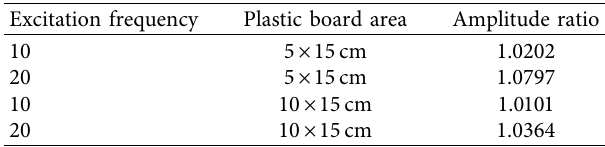
Figure 5: Vibration curves of stone piers and stones. (a) Stone pier vibration curve. (b) Block vibration curve. Table 1: Rock-block vibration test results. Table 2: Calculation result of length of rock